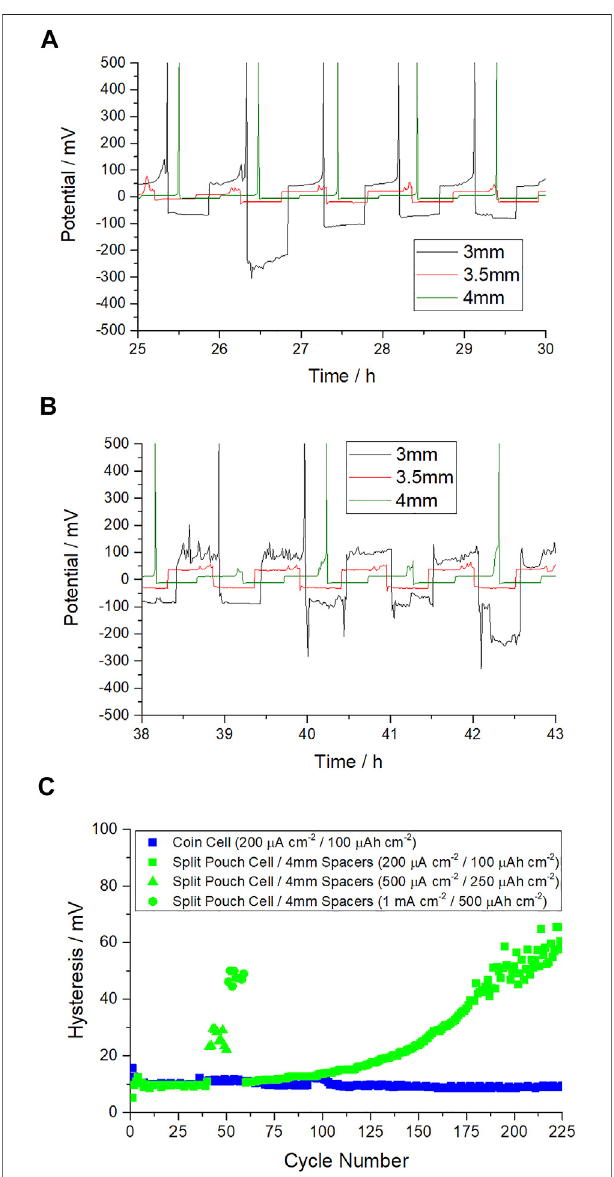
FIGURE 3 | (A) Voltage-time graph of Na||Cu half cells in split pouch cell format with increasing spacer thickness focusing on the voltage hysteresis at 0.2 mA cm − 2 /0.1 mAh cm − 2 (B) , as before but with 0.5 mA cm − 2 / 0.25 mAh cm − 2 (C) Hysteresis throughout cycle life in pouch cell format at 0.2 mA cm − 2 /0.1 mAh cm − 2 using 4 mm of spacers vs. coin cell.